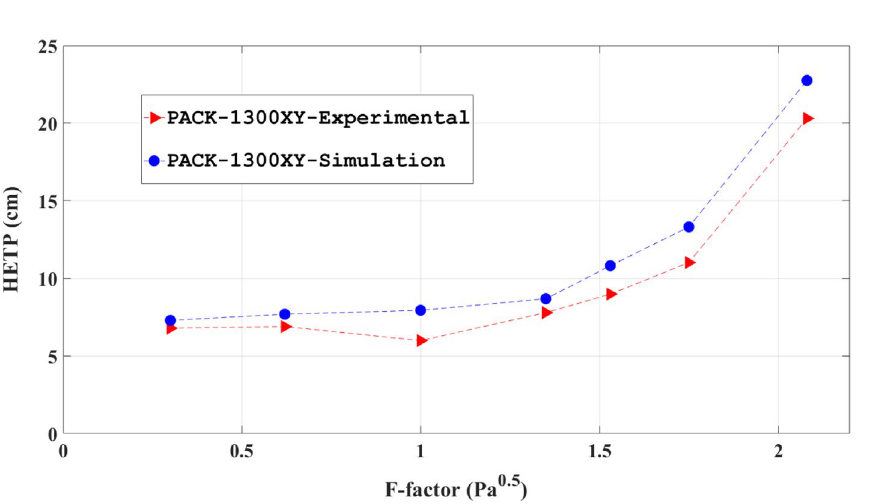
Figure 5. The experimental measurements (red triangle) and numerical predictions (blue circle) of the HETP of the